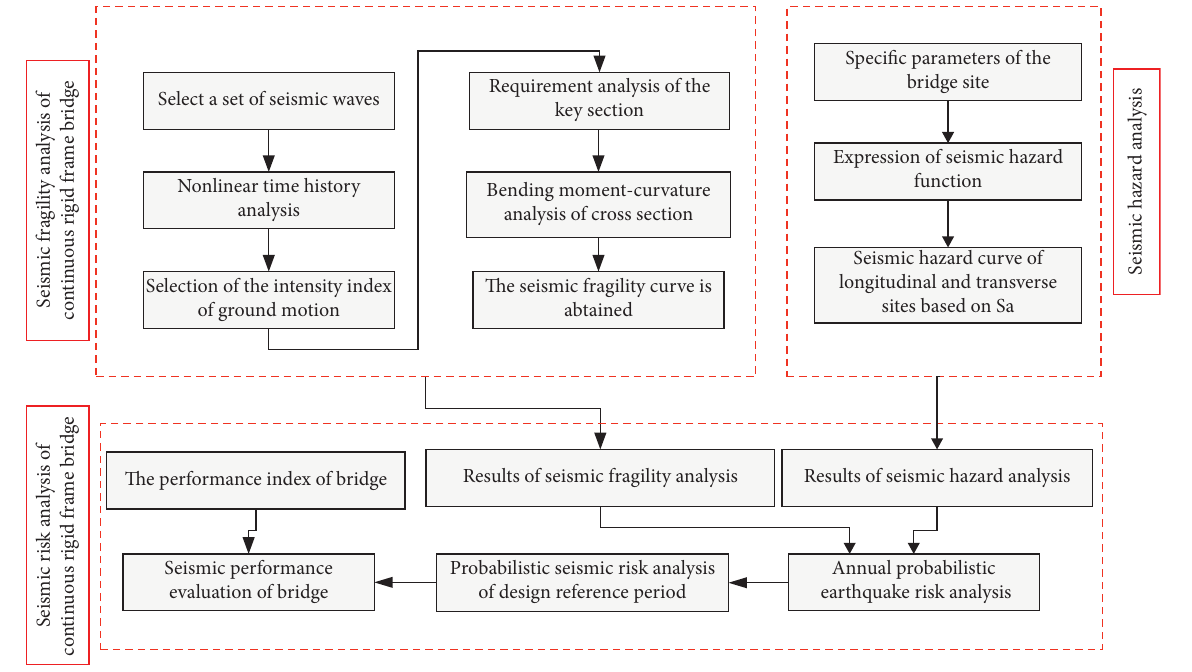
Figure 2: The general framework of the analysis implemented in this